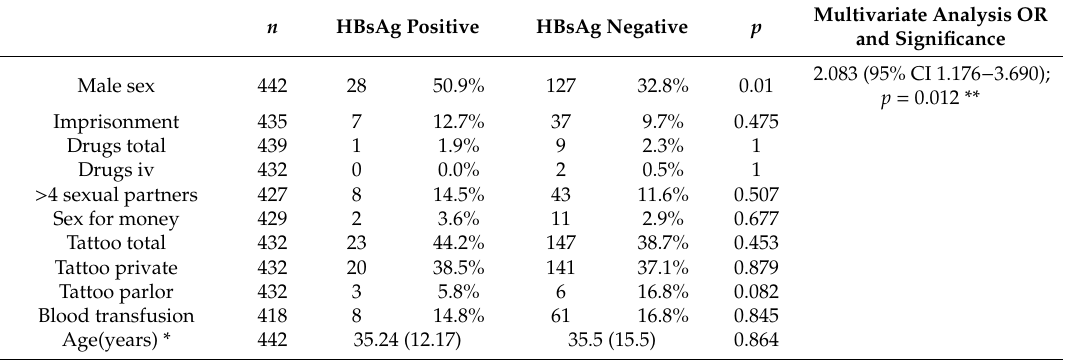
Table 4. A comparison of imprisonment, drug use, blood transfusion, sexual behavior and tattoo procedure between HBsAg-positive and -negative Roma people. HBsAg Positive